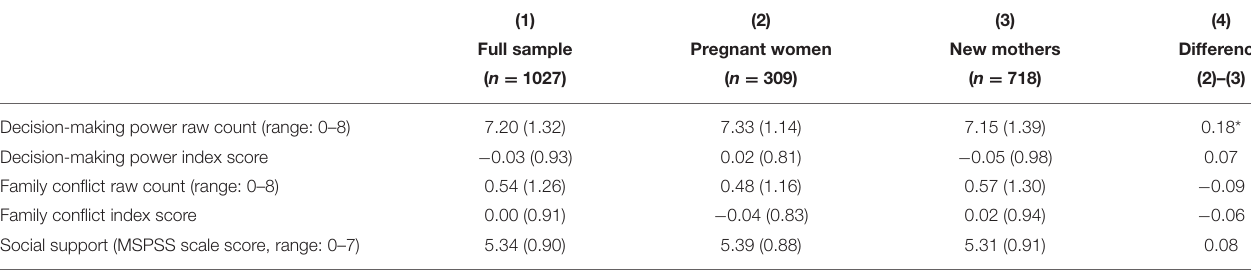
TABLE 2 | Summary statistics for social risk factors among full sample and subgroups.